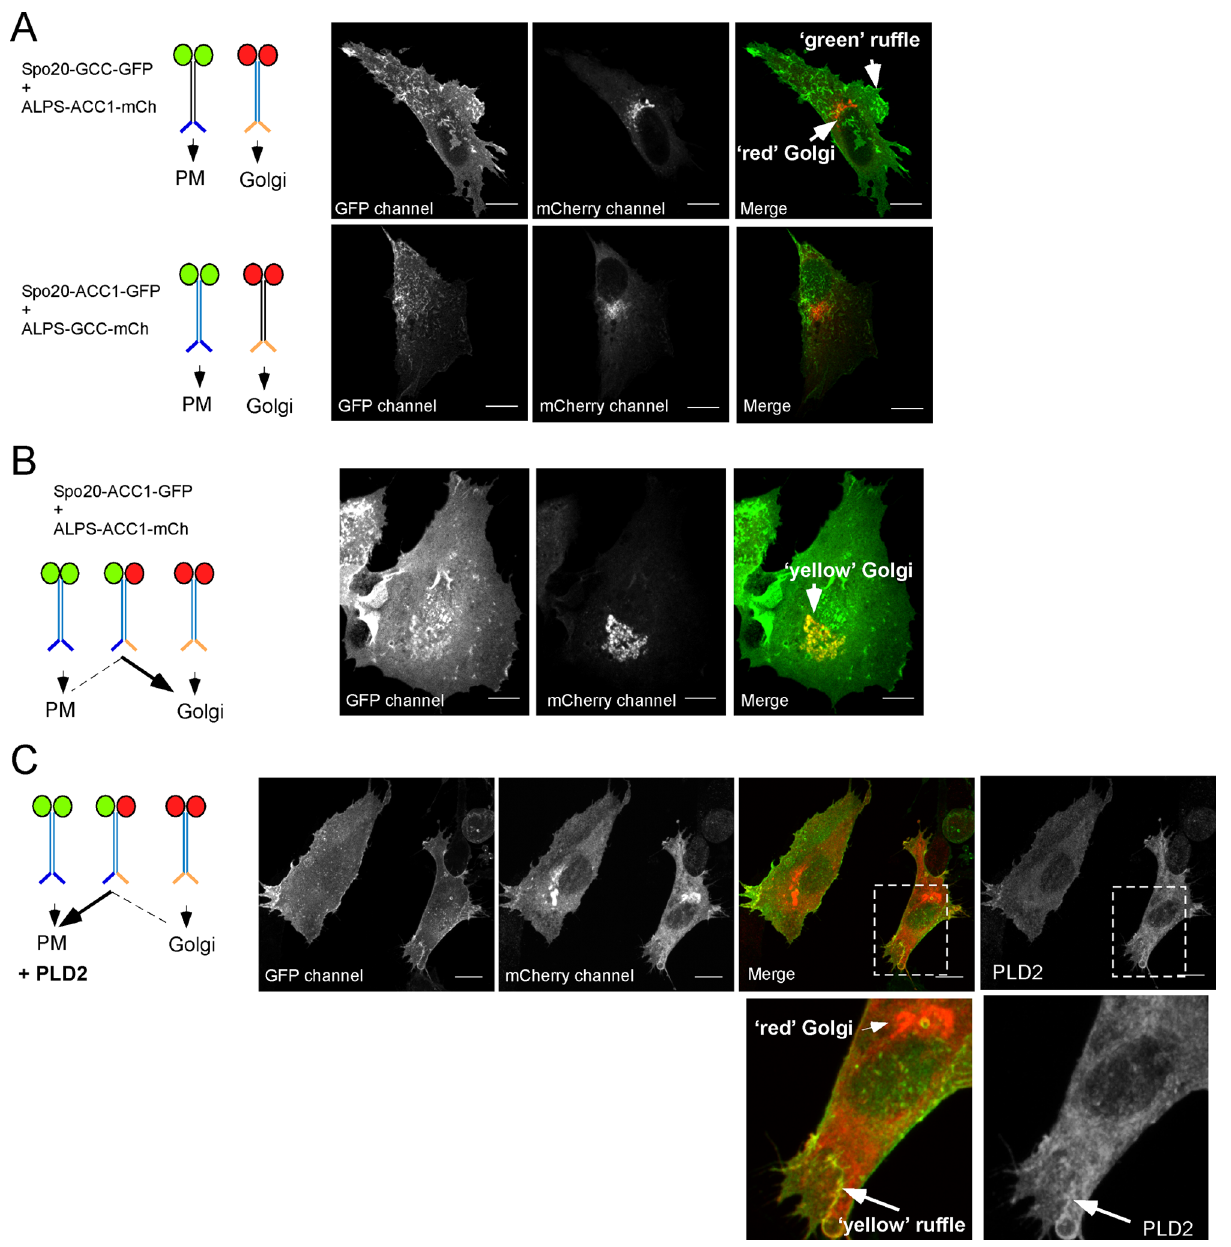
Figure 8. Effect of PLD2 overexpression on the subcellular localization of coiled-coil probes. ( A ) Spo20-GCC-GFP and ALPS-ACC1-mCherry were coexpressed in RPE1 cells. Because the two constructs contain different coiled-coil domains they form homodimeric probes. Spo20-GCC-GFP/Spo20- GCC-GFP stains ruffles at the plasma membranes, whereas ALPS-ACC1-mCherry/ALPS-ACC1-mCherry stains the Golgi apparatus. ( B ) Coexpression of Spo20-ACC1-GFP and ALPS-ACC1-mCherry. Because the two constructs contain the same coiled-coil, they not only homodimerize but also form the heterodimer Spo20-ACC1-GFP/ALPS-ACC1-mCherry. The dual color of the Golgi apparatus (green + red 5 yellow) indicates that the heterodimer is directed towards this compartment. ( C ) Same as in ( B ) but in cells overexpressing PLD2. Some plasma membrane ruffles where PLD2 localizes appear yellow, whereas the Golgi apparatus is completely red, suggesting that the Spo20-ACC1-GFP/ALPS-ACC1-mCherry heterodimer is redirected from the Golgi apparatus to the plasma membrane upon the action of PLD2. Scale bars 5 10 m m.